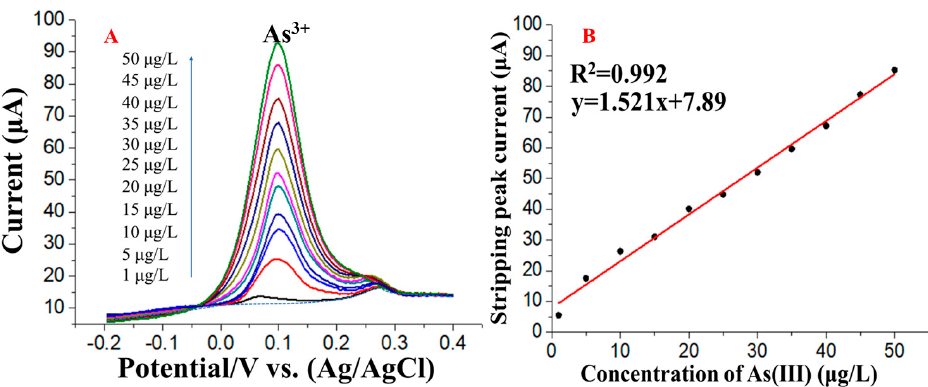
Figure 7. ( A ) SWASV response curves of rGO-Au nano /GCE for the detection of different concentrations of As(III) and ( B ) the corresponding relationship between concentration and peak current in the concentration range from 1 μ g/L to 50 μ g/L (deposition time: 250 s).